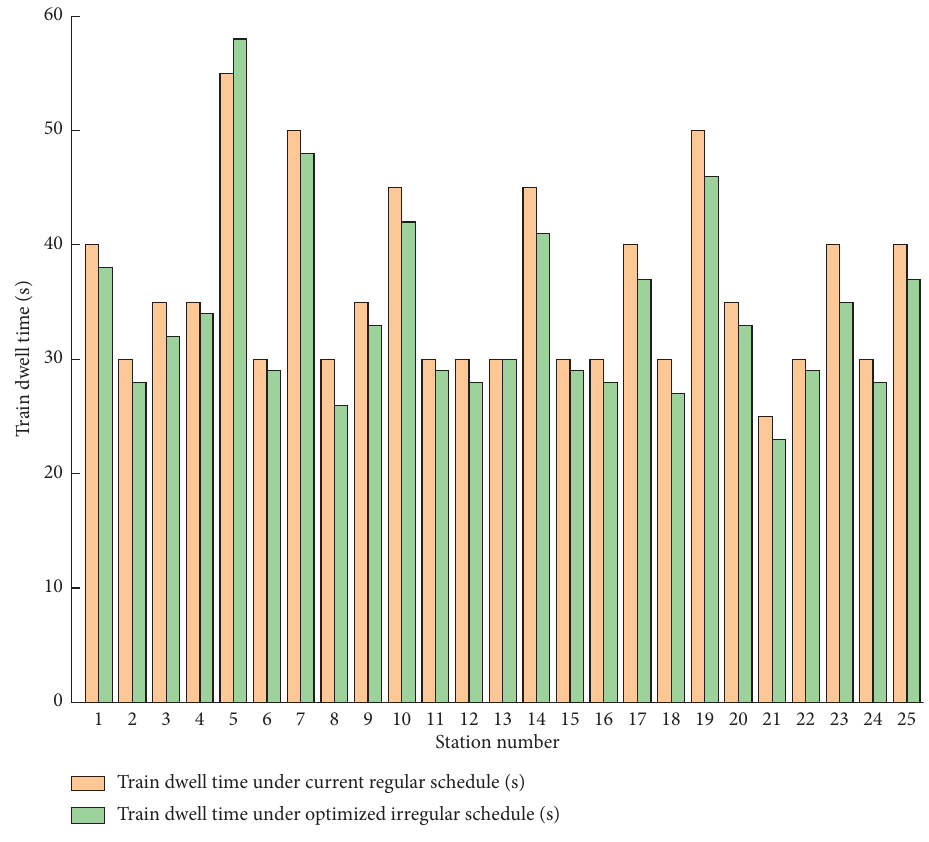
Figure 4: Train dwell times under optimized irregular schedule and current regular